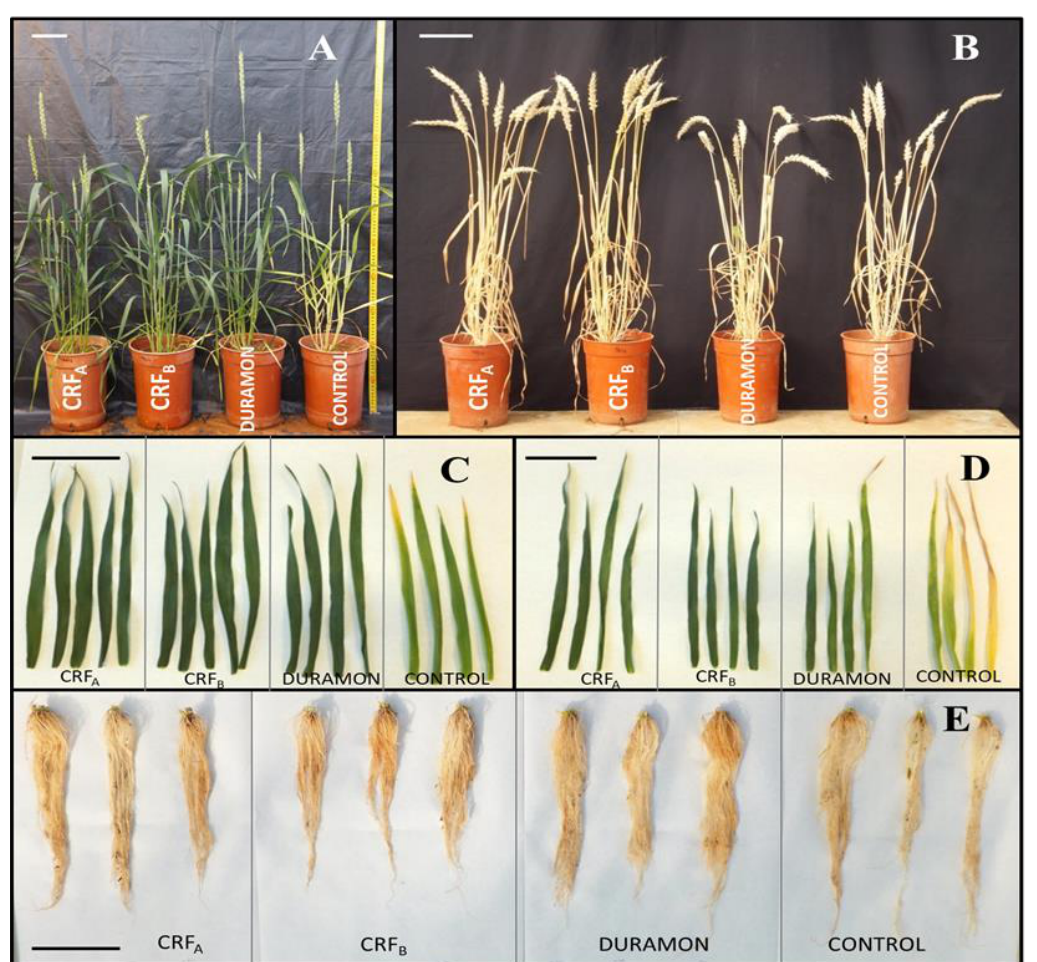
Figure 1. Responses of fertilizer treatments on plant growth ( A , B ), foliar area ( C , D ) and root development ( E ) of Triticum aestivum in the phenological state of panicles swelling ( A , C , D , E ) and at the end of the experiment ( B ). Treatments from left to right: CRF A , CRF B , DURAMON ® , and CONTROL. Bars correspond to 10